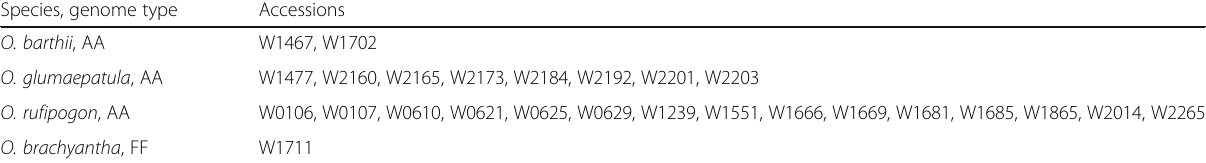
Table 6 Accessions used to generate transgenic plants expressing GFP Species, genome